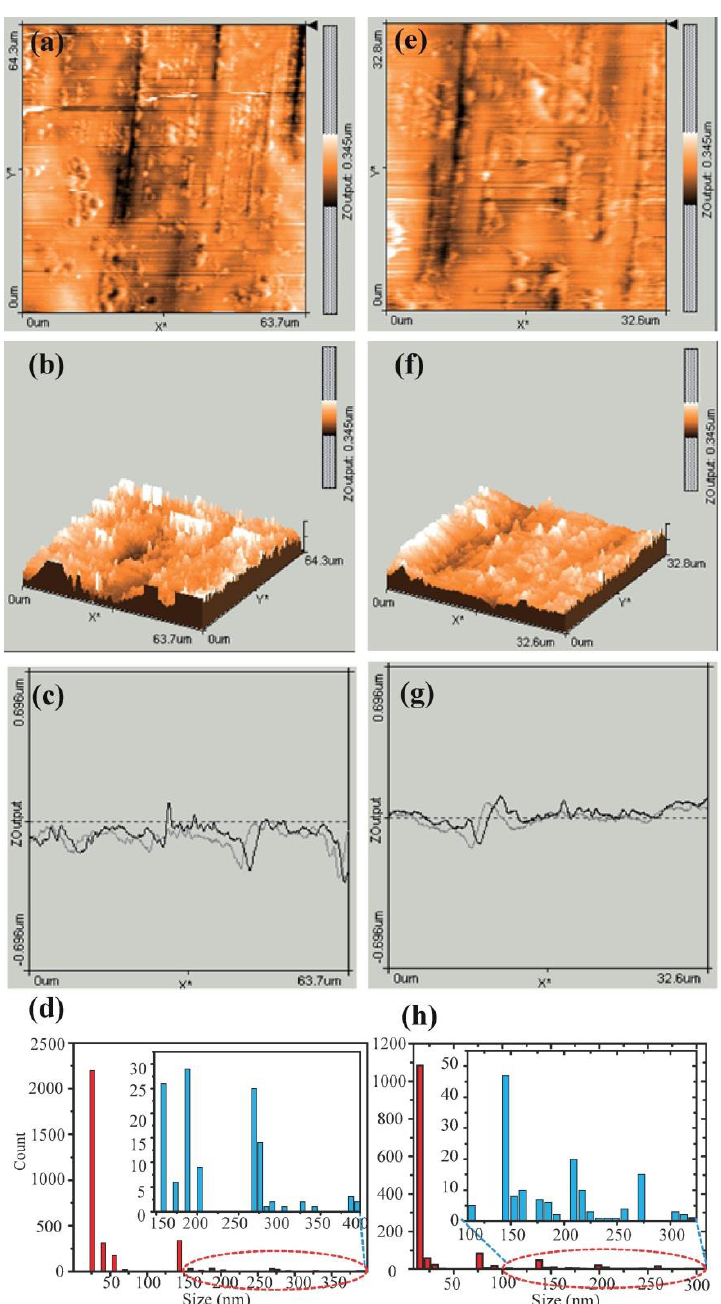
Figure 5. AFM images of the nanocluster deposited at pressure, voltage, and current of 50 mbar, 0.23 kV, and 240 mA, respectively. ( a ) and ( b ) Two-dimensional and 3-dimensional views of the low-resolution AFM scan of 63.7 µm × 64.3 µm. ( c ) and (g) AFM scan profile for low-resolution and high resolution captured during scanning. ( d ) Histogram of nanocluster size versus frequency shown in ( a ) and ( b ). ( e ) and ( f ) are two-dimensional and three-dimensional views of the high-resolution AFM scan of 32.6 µm × 32.8 µm. ( h ) Histogram of the nanocluster of a high-resolution AFM scan as shown in ( e ) and ( f ).